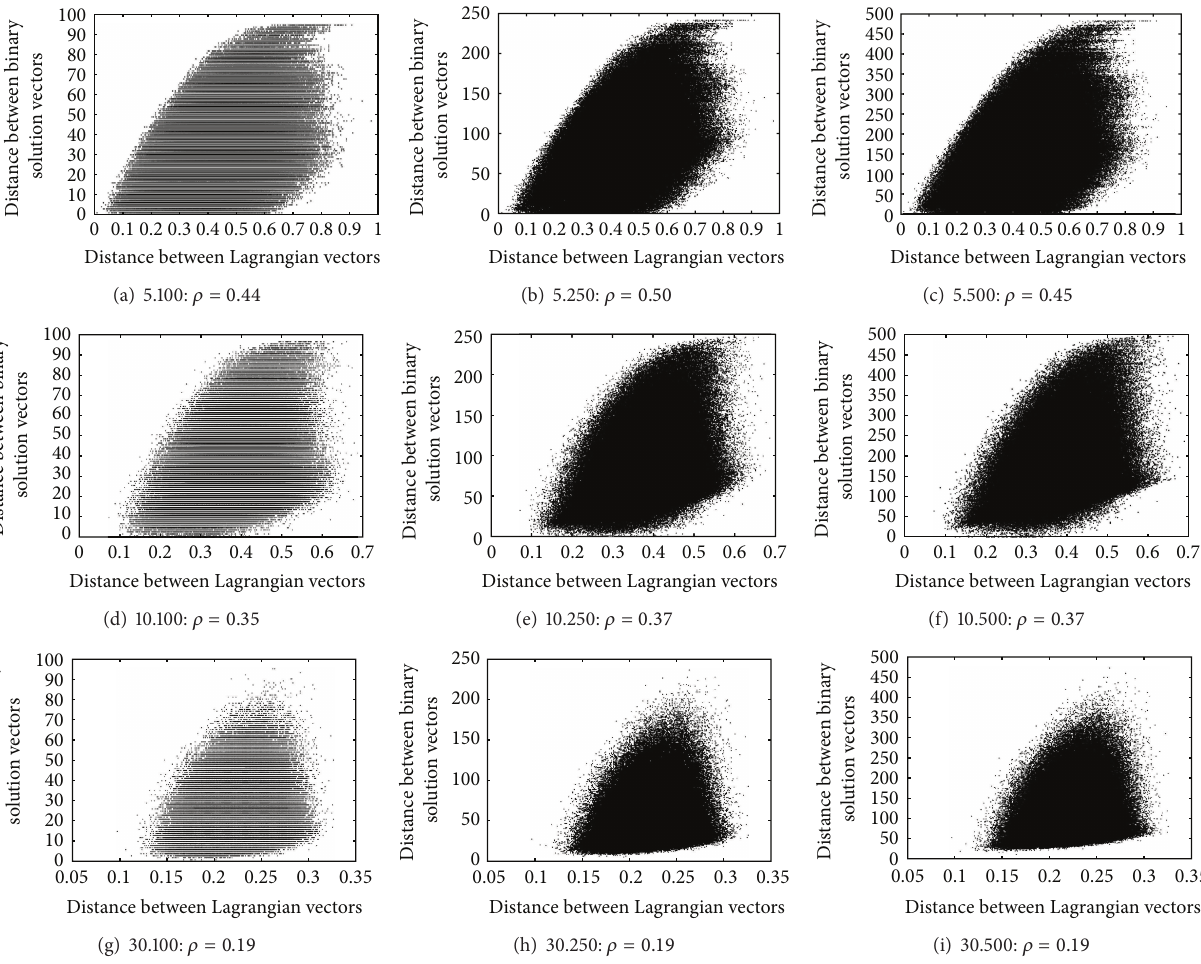
Figure 1: Relationship between distances on solution space and those on Lagrangian space (among randomly generated Lagrangian vectors). ∗ 𝑥 -axis: distance between Lagrangian vectors, 𝑦 -axis: distance between binary solution vectors, and 𝜌 : Pearson correlation